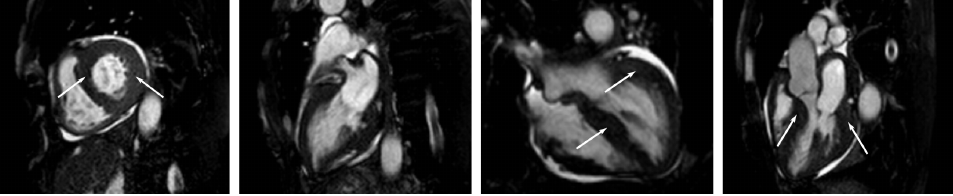
Figure A5. Short-axis cine image and long-axis cine images show marked, concentric left ventricular hypertrophy (white arrows) in a patient with cardiac